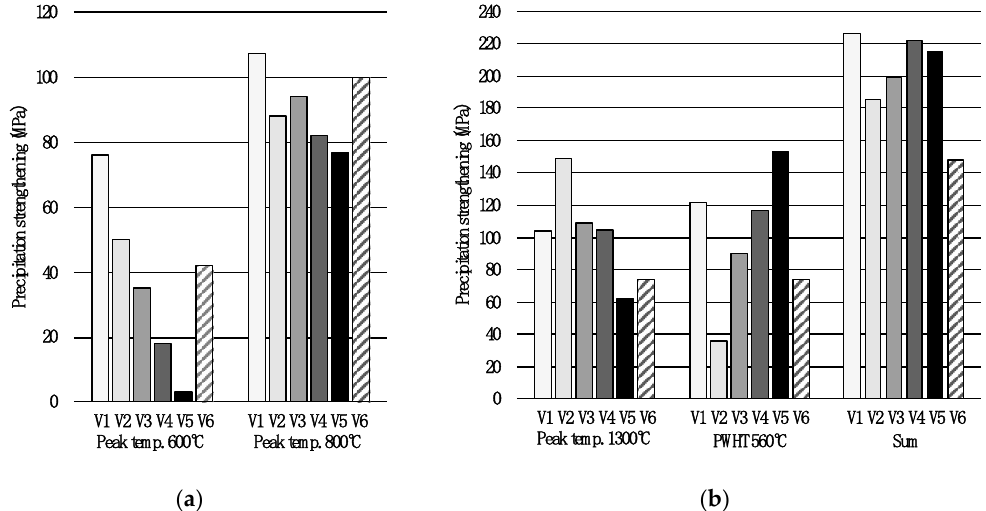
Figure 11. Precipitation strengthening effect in HAZ sub-zones for alloy variants containing 0.10%Nb: ( a ) Sub-critical zone at peak temperatures of 600 and 800 °C; ( b ) coarse-grained zone (peak temperature 1300 °C), precipitation effect of PWHT (560 °C / 30 min.) and sum of precipitation strengthening (CGZ + PWHT).